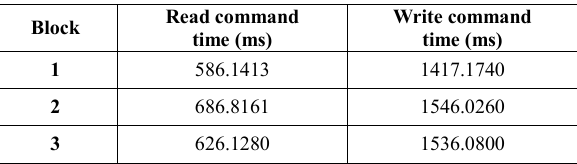
Table 1. Results of times taken by the read and write commands.